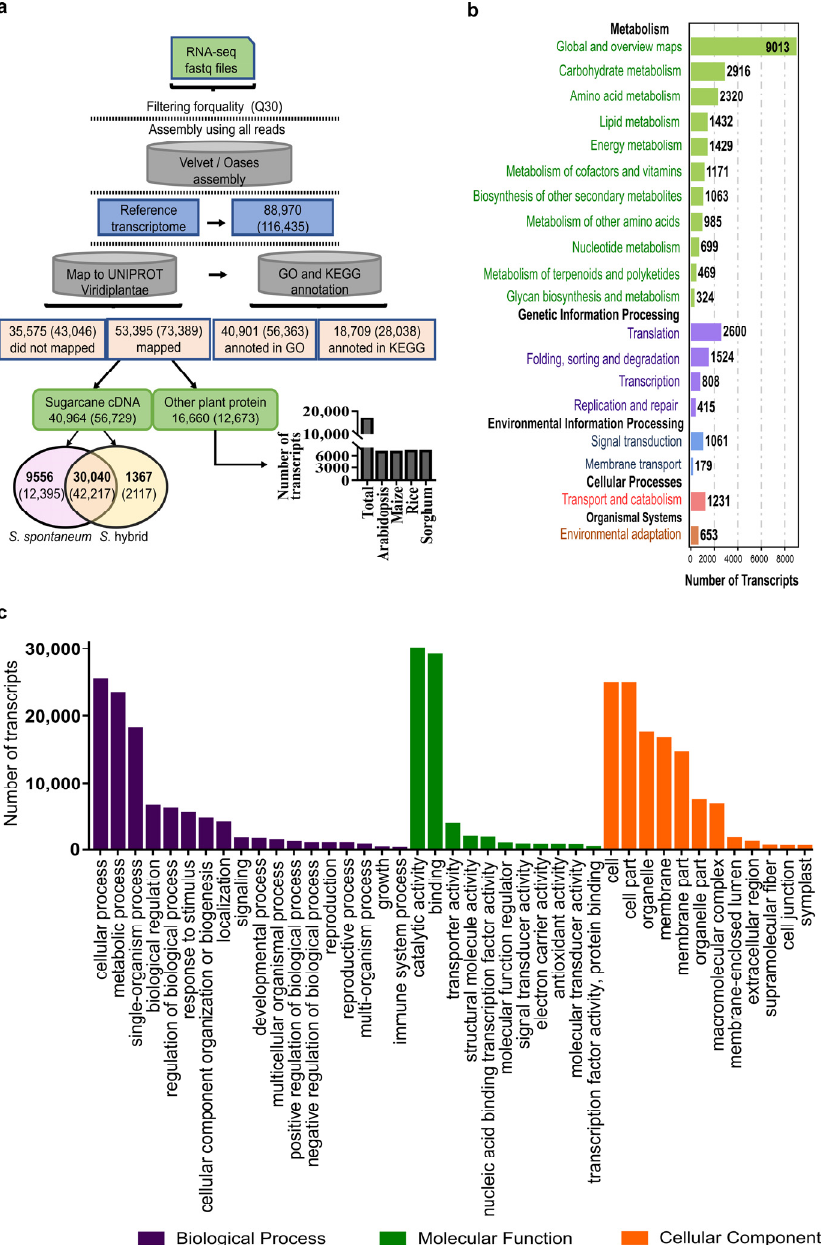
Figure 1. Pipeline of the construction of the sugarcane reference transcriptome. ( a ) A total of 16 libraries were analyzed and sequencing results were used to construct a sugarcane reference transcriptome. Over 130 million reads were used for Velvet-Oases pipeline assembly that resulted in 88,970 loci and 116,435 transcripts. A total of 53,395 loci mapped with plant sequence databases and, within these, 40,964 matched with sugarcane genome sequences available in public databases.